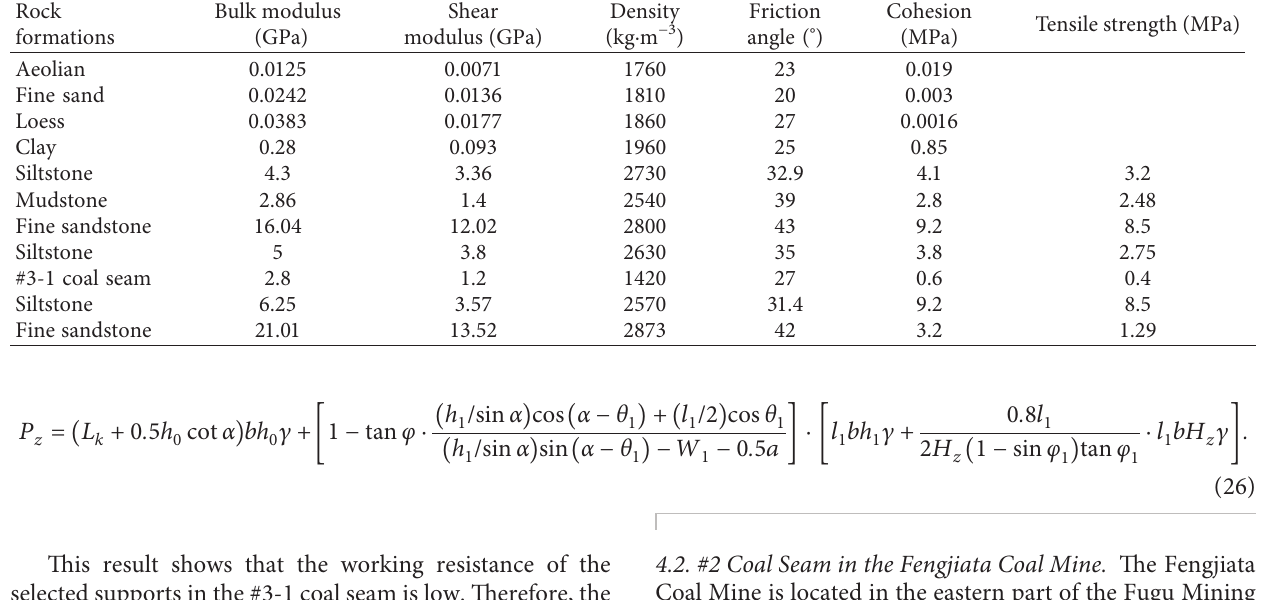
Table 1: Physical and mechanical parameters of the coal strata in the Liangshuijing coal